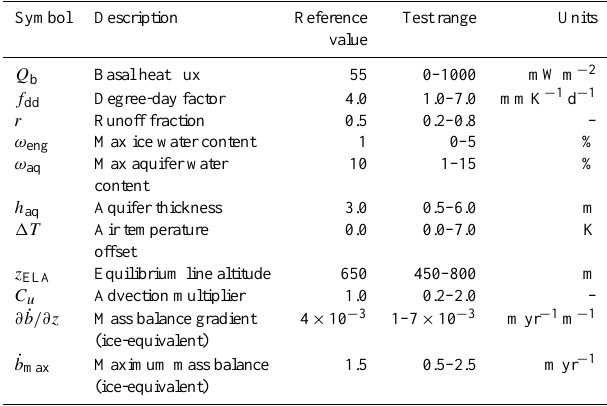
Table 2. Environmental parameters varied in model sensitivity